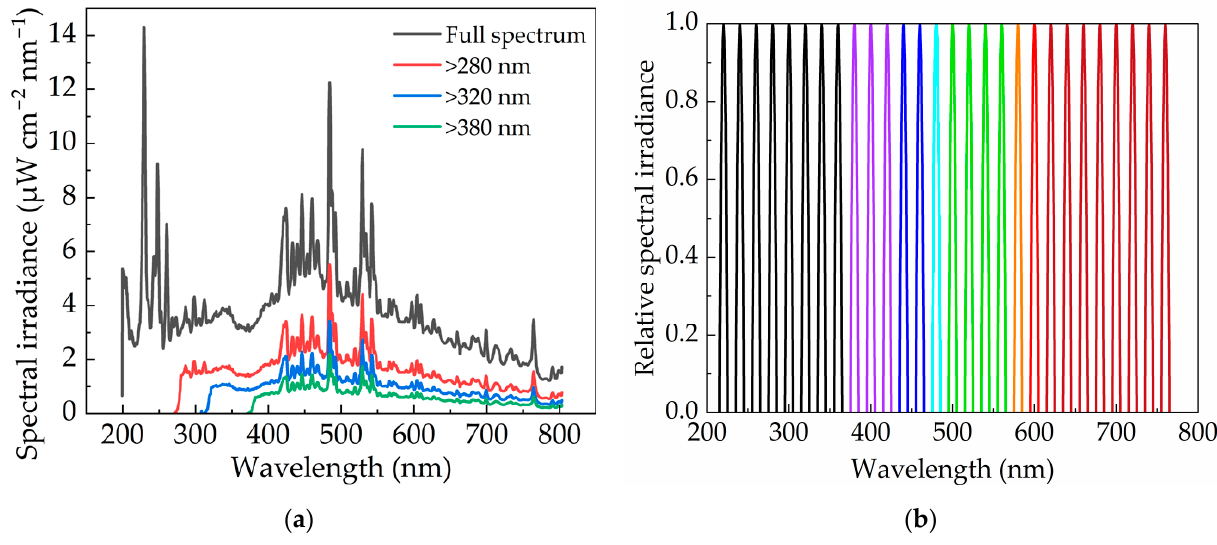
Figure 8. Spectral power distribution of the pulsed xenon lamp under ( a ) long-wave pass and ( b ) band-pass filters.